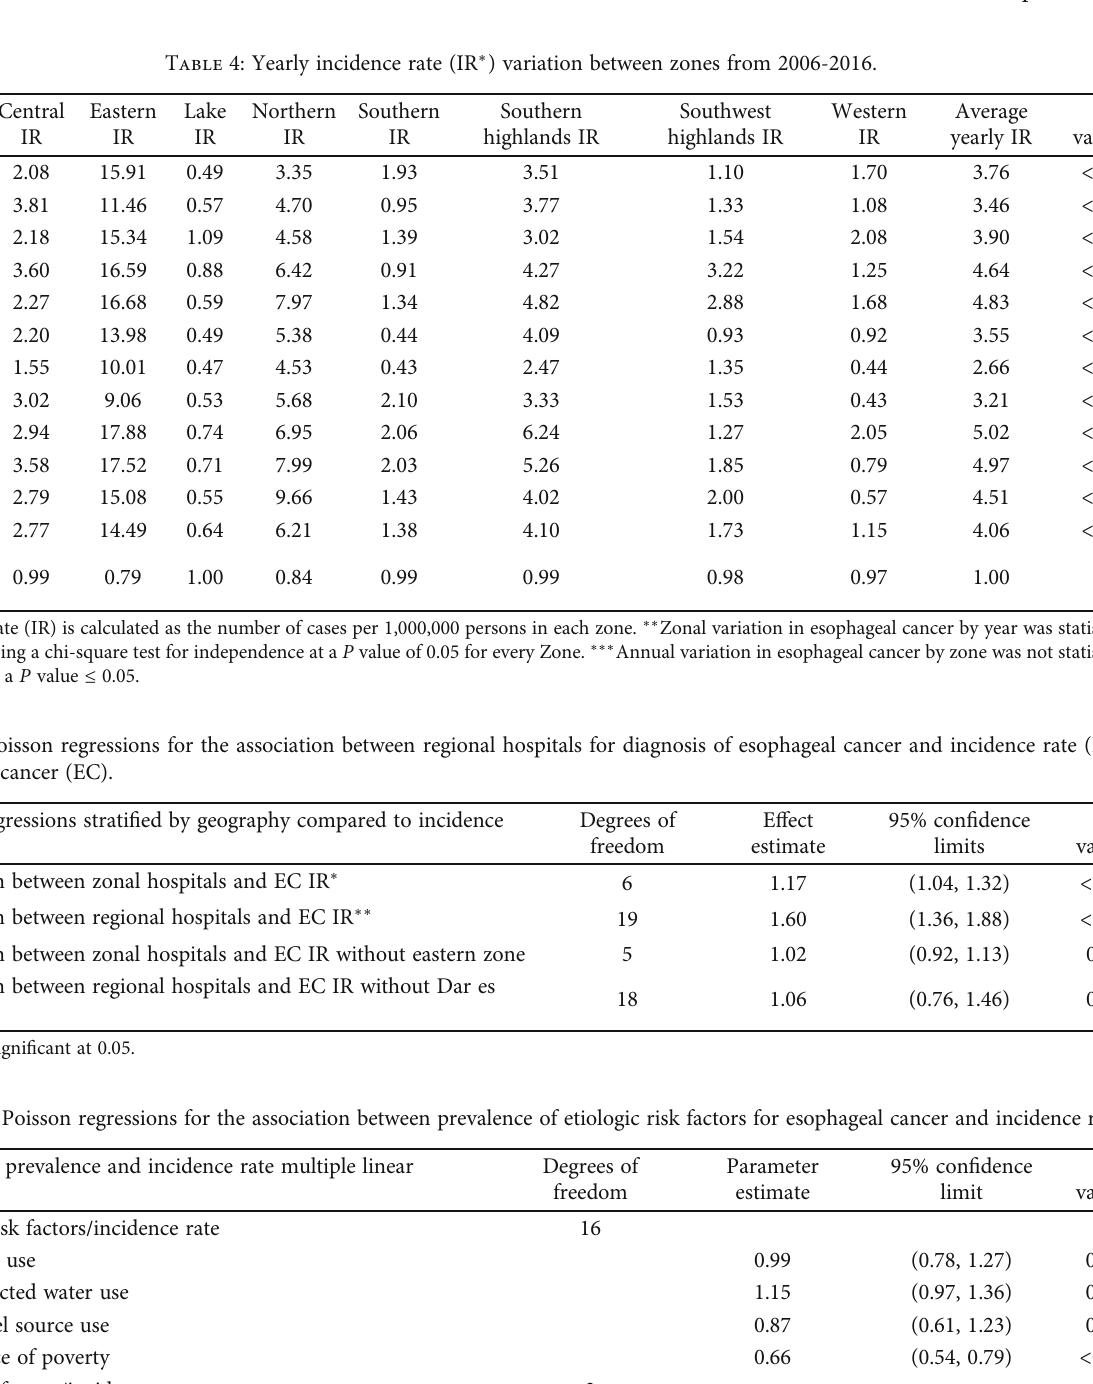
Table 4: Yearly incidence rate (IR ∗ ) variation between zones from 2006-2016. Central Eastern Year IR IR